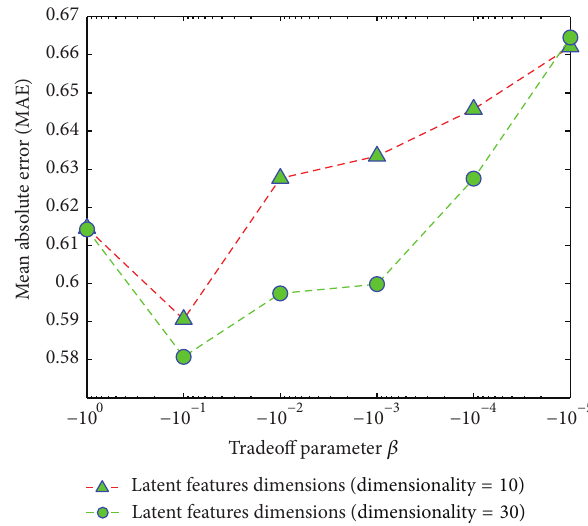
Figure 10: Impact of tradeoff parameter 𝛽 with different dimensions of latent